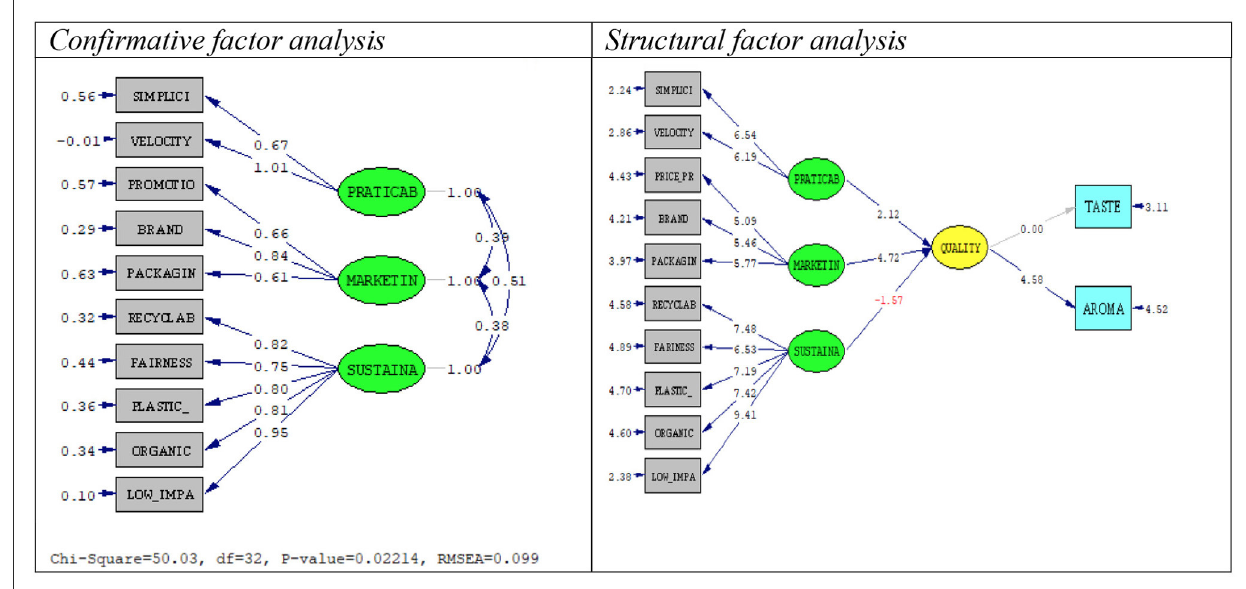
FIGURE6 Confirmative and structural analysis for older